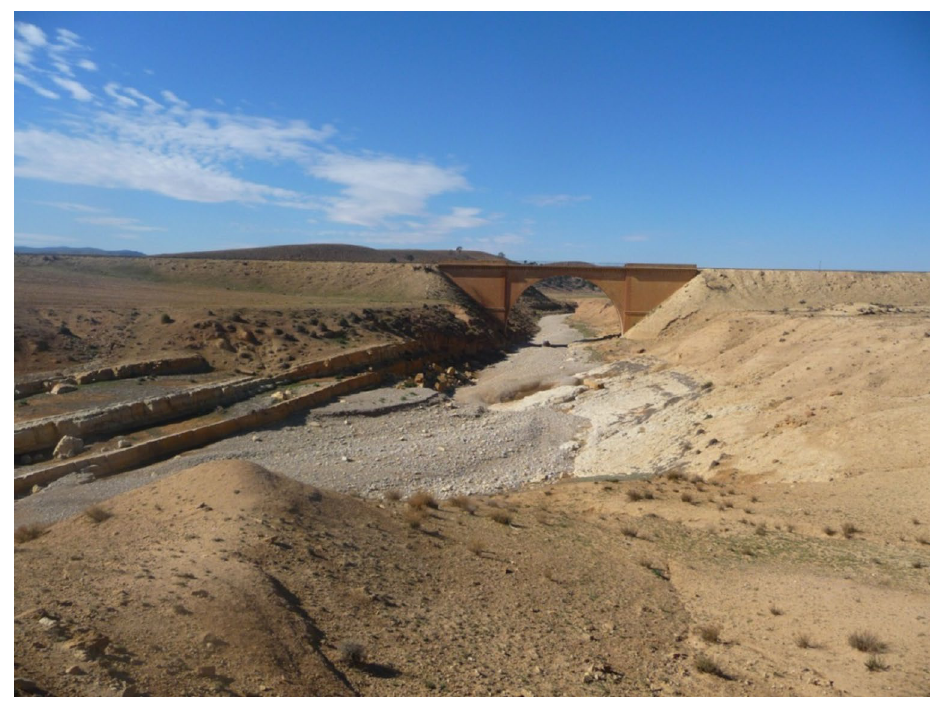
Fig. 3 Sidi Slimane River (March